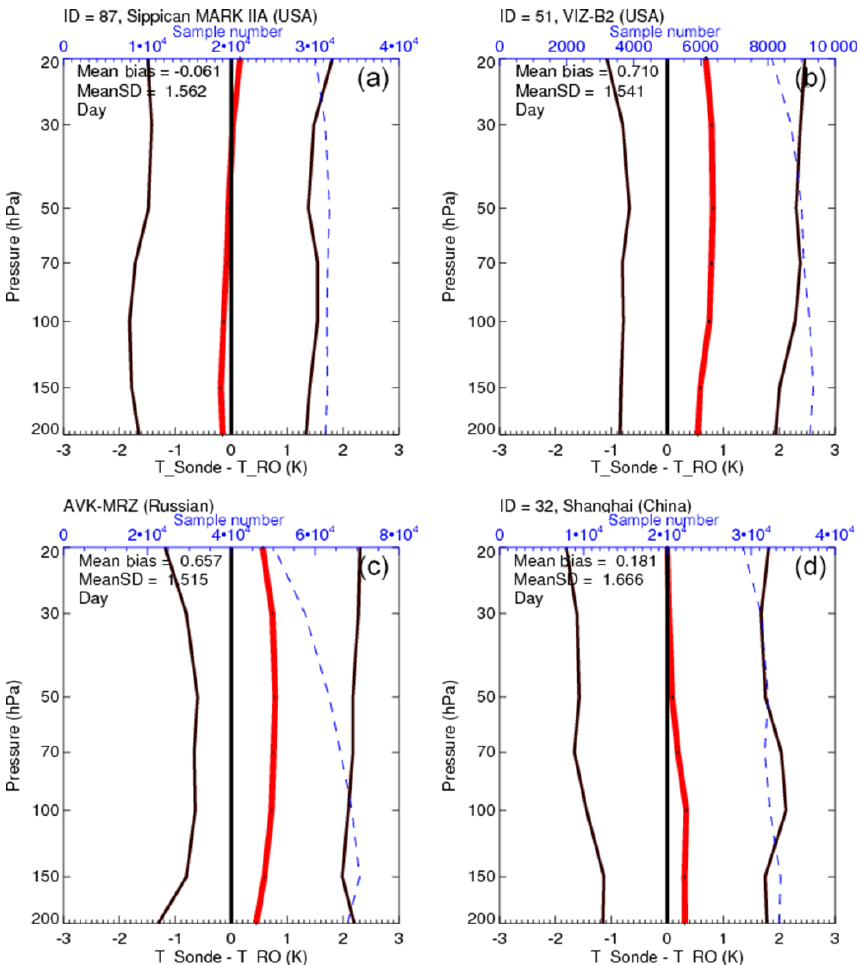
Figure 6. Comparisons of temperature between radiosonde and RO during the daytime for (a) Sippican over United States minus RO, (b) VIZ-B2 over United States minus RO, (c) Russian sonde minus RO, (d) Shanghai minus RO. Table 3. Mean, standard deviation (SD) of monthly temperature differences (K), de-seasonalized trend of temperature differences (K/5yr), and root mean square (RMS) of de-seasonalized RS92–RO temperature difference time series at 50hPa over United States, Australia, Ger- many, Canada, United Kingdom, and Brazil. United States Australia